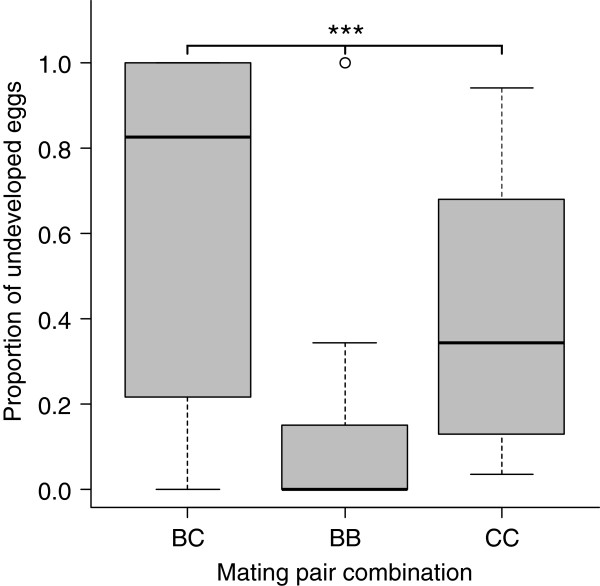
The proportion of eggs that failed to develop across the mating pair types. In each combination, female species is denoted by the first letter, and male species by the second. Data are displayed as medians (thickened line) and inter-quartile ranges (grey boxes), circles are outlying values. There are significant differences between all mating pair combinations. Statistical significance from glm (see text): *** P < 0.001.